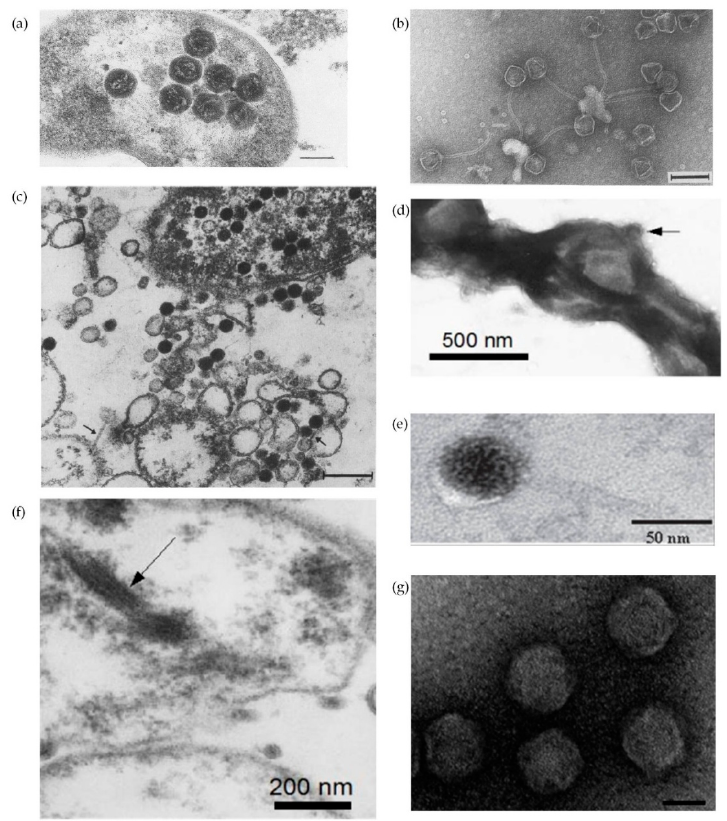
Figure 3. Electron micrographs of H. pylori phages: ( a ) Thin section of H. pylori carrying phage particles with phage head diameter of about 85 nm. Bar = 100 nm (adapted with permission from [53]); ( b ) Negative staining of H. pylori phage HP1. Phage head diameter of about 50 to 60 nm and